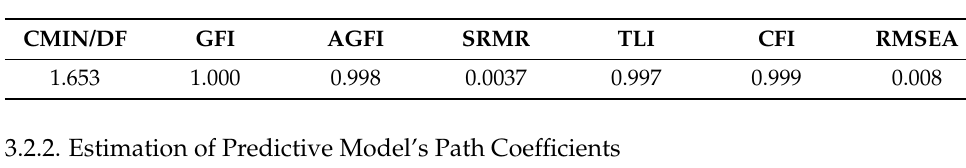
Table 2. The goodness of fit of the predictive